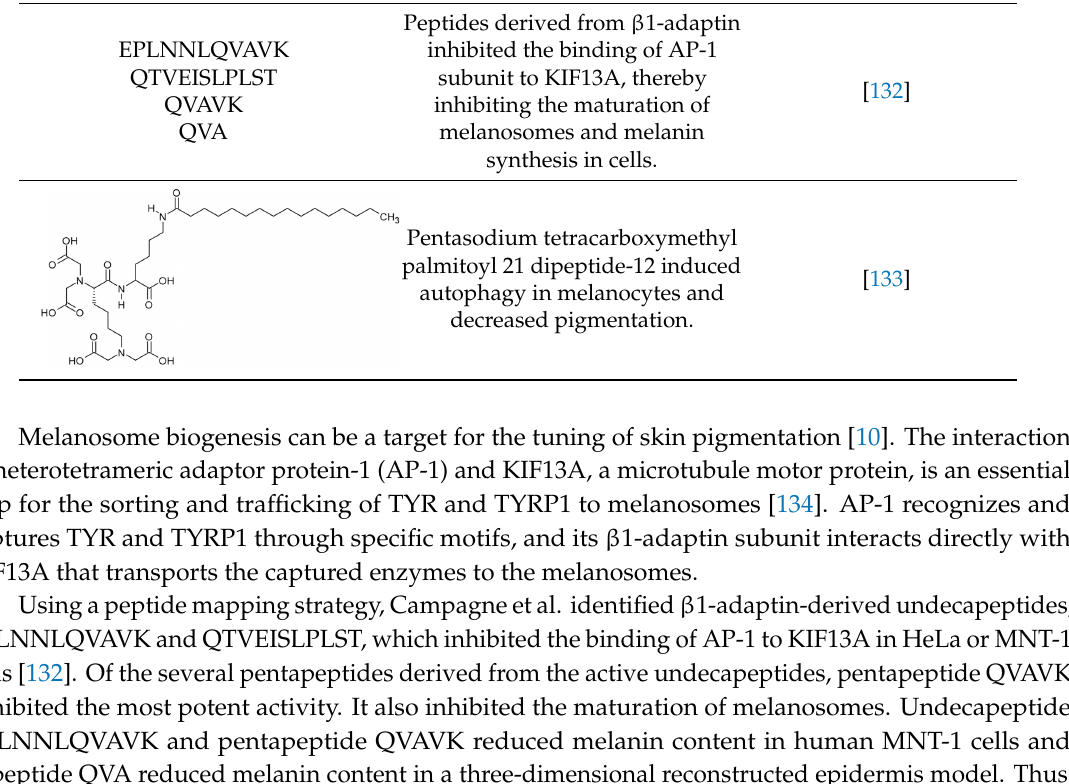
Table 6. Peptides and peptidic compounds that inhibit melanosome biogenesis or induce autophagy in melanocytes. Compounds Key Points Literature Peptides derived from β 1-adaptin Compounds Key Points Literature EPLNNLQVAVK inhibited the binding of AP-1 Peptides derived from β 1-adaptin EPLNNLQVAVK inhibited the binding of AP-1 subunit to KIF13A, thereby QTVEISLPLST subunit to KIF13A, thereby inhibiting the maturation of [132] QVAVK inhibiting the maturation of QVA melanosomes and melanin QVA melanosomes and melanin synthesis in cells. synthesis in cells.